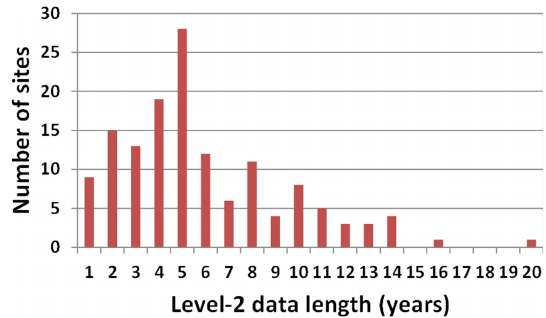
Fig. 4. Distribution of data record lengths in years for the 142 Amer- iFlux sites with available Level 2 data products based on the CDIAC AmeriFlux data collection in January 2013.